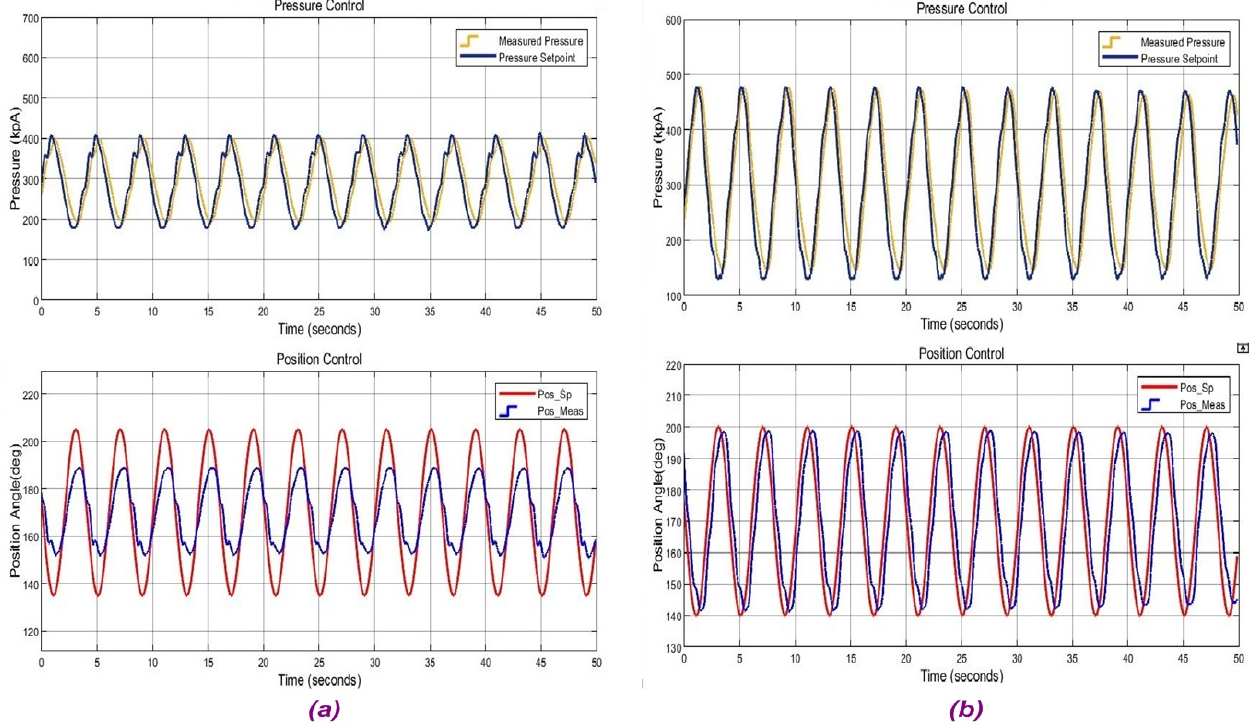
Figure 19. Performance comparison results for 0.25 Hz sinusoidal reference position tracking: ( a ) PID-only operation and ( b ) NARX active operation.